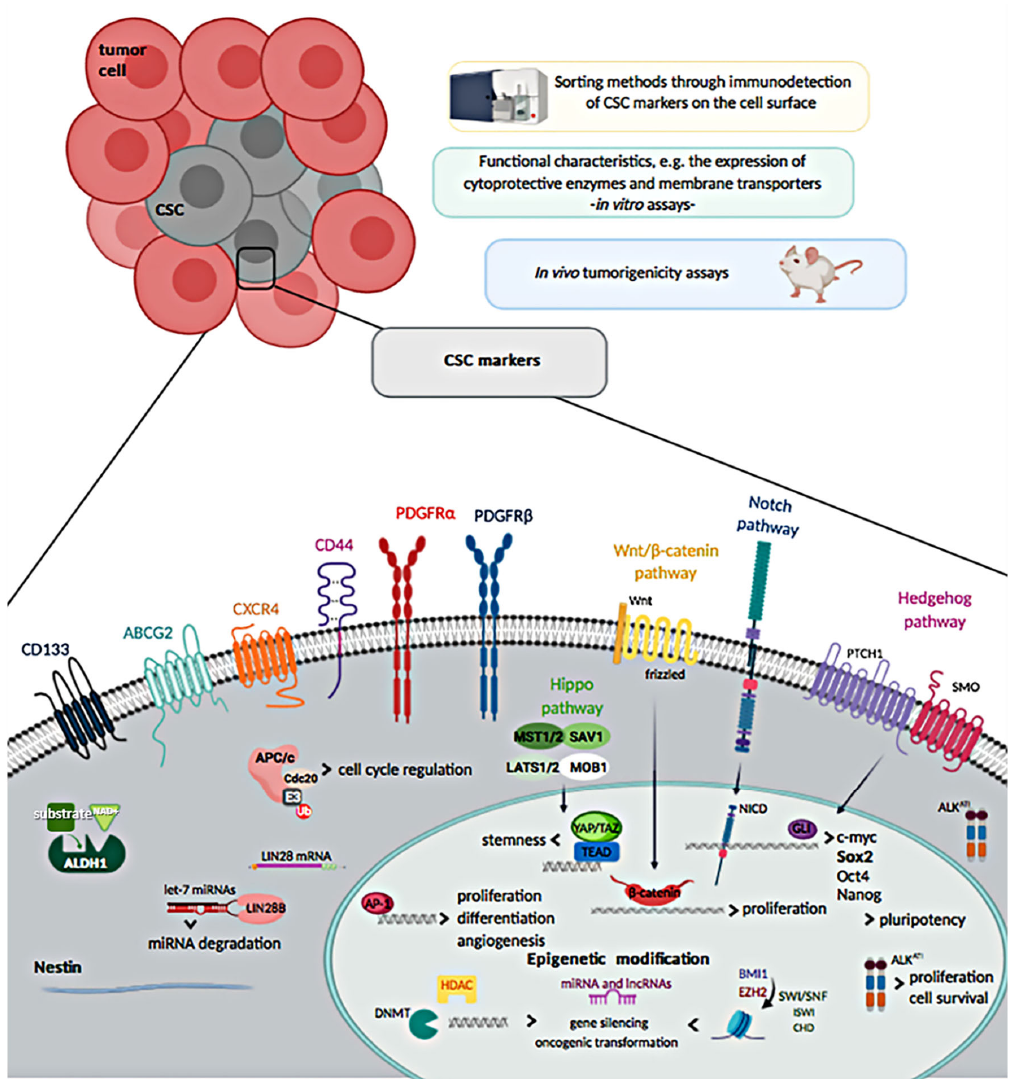
Figure 1. Methods to isolate cancer stem cells (CSCs) and overview of soft-tissue sarcoma CSCs markers.